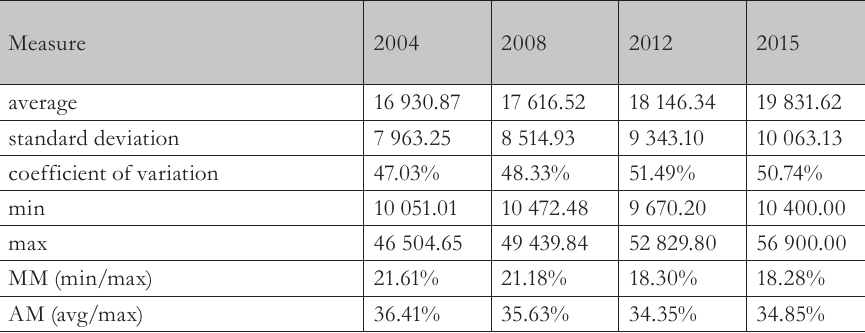
Tab. 5 – Selected measures describing the level of the regional GDP pc and its diversification in Poland in selected years [data in EUR according to PPS (2015=100)]. Source: Own calcula- tions based on Eurostat database (access: 03.2018)